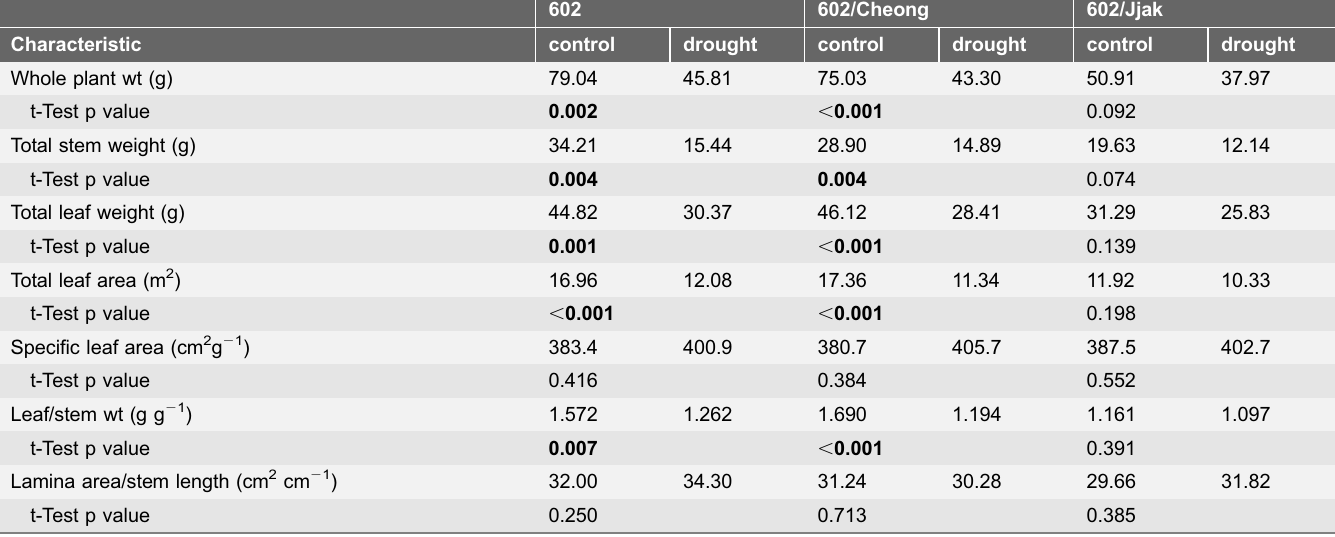
Table 2. Comparison between three lines of tomato plants treated with either mild-drought or no-drought (control).